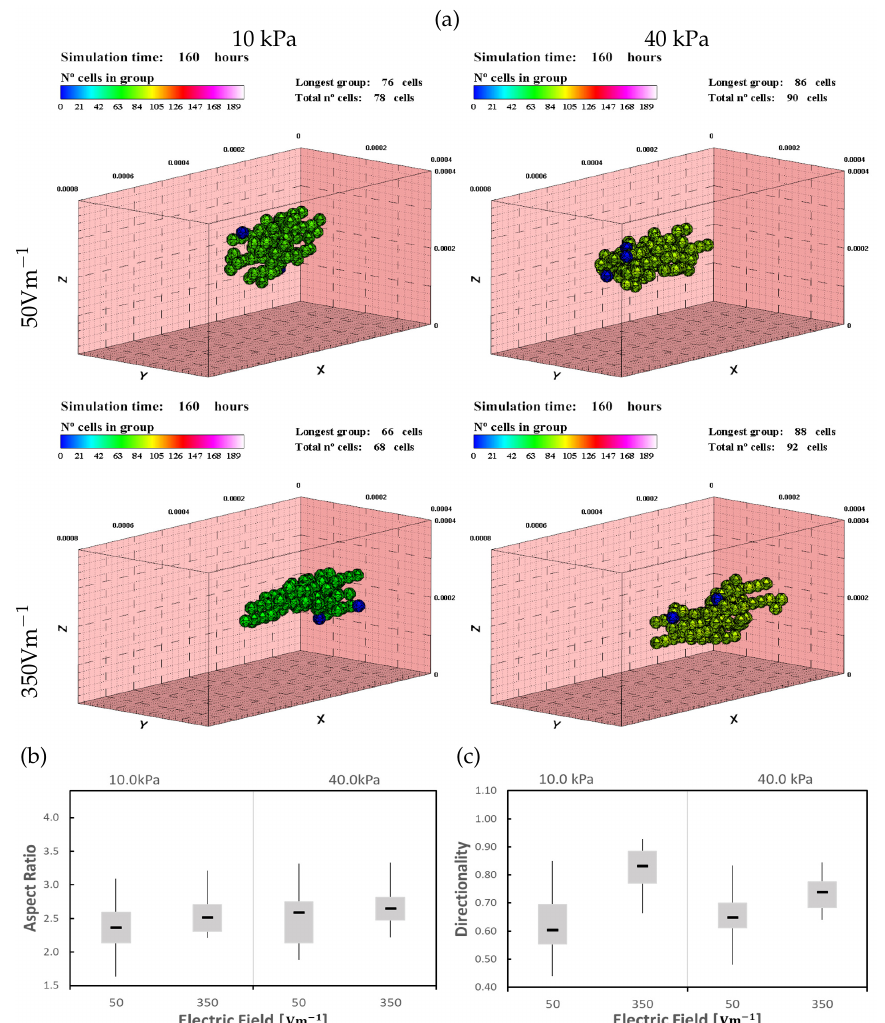
Figure 8. CMs in 10 and 40 kPa ECMs, under electrical pulsatory stimulation of 50 and 350 Vm − 1 , after 160 h of simulation (see also Supplementary Materials video 2). ( a ) Less effect of the electric field is observed with a greater tendency of the cells to remain close to the center of the ECM. AR ( b ) and directionality ( c ) increase as the Electrical stimulation (ES)